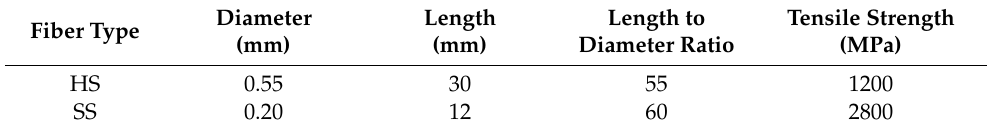
Table 1. Physical parameters of steel fibers.